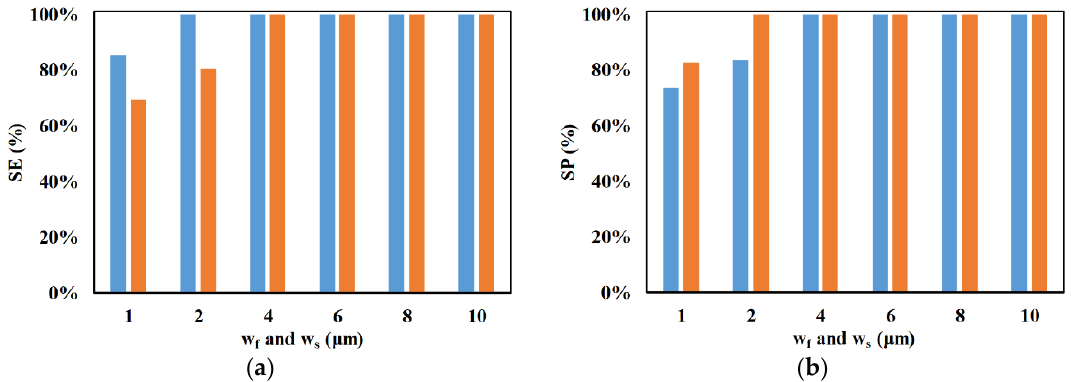
Figure 9. Variation of SE and SP with electrode widths ( w f and w s ) for ( a ) ■ 2 μm and ( b ) ■ 2.25 μm ( d f = 60 μm, l f = 120 μm, d s = 60 μm, l s = 120 μm, n f = 200, n s = 200, Q m = 200 μL/h, V 1 = 3 V pp , V 2 = 15 V pp , V 3 = 15 V pp V 4 = 3 V pp , H ch = 50 μm, W ch = 50 μm, N 1 = N 2 = 10 MHz, 0 < W o,2.25 < 30 μm, 30 μm < W o,2 < 50 μm , N 3 = N 4 = N cr,2 = 473 kHz).